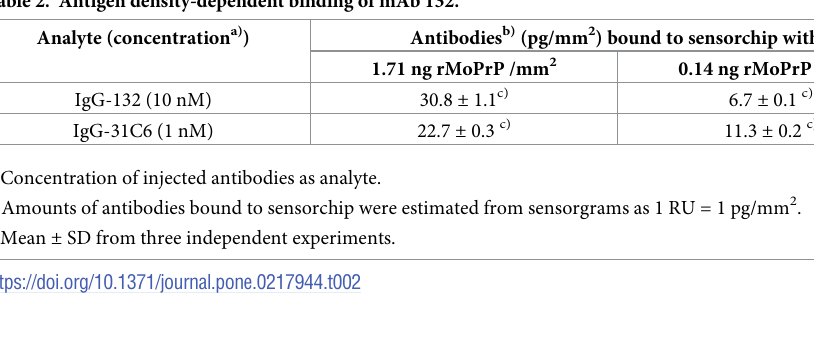
ever, mAb 132 did not react with PrP C on the non-treated control N2a-3 cells (Fig 7 and S2